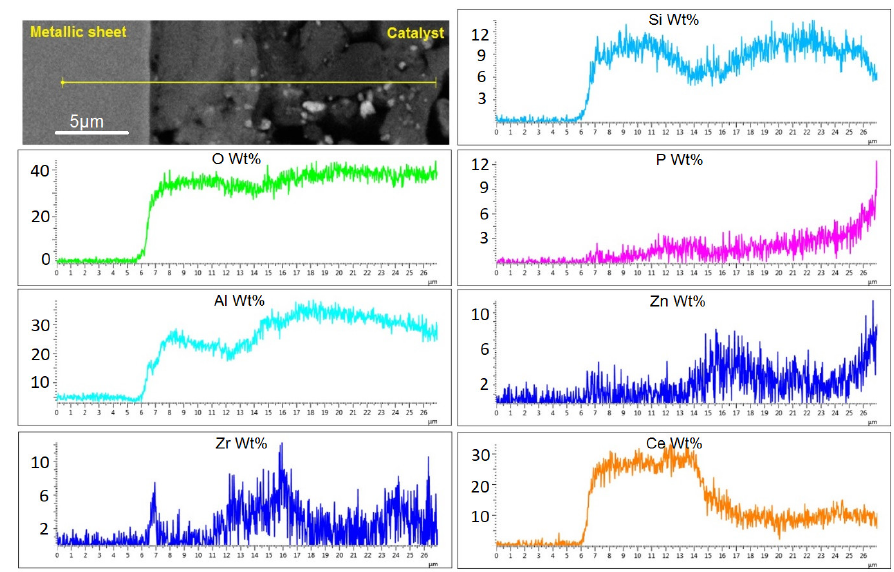
Figure 13. SEM-EDS line analysis from the vehicle-aged natural gas (inlet) catalyst.